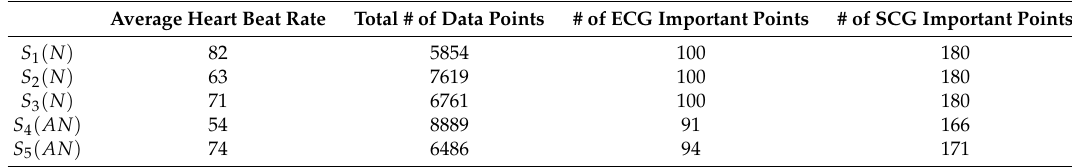
Table 5. Samples of ECG and SCG